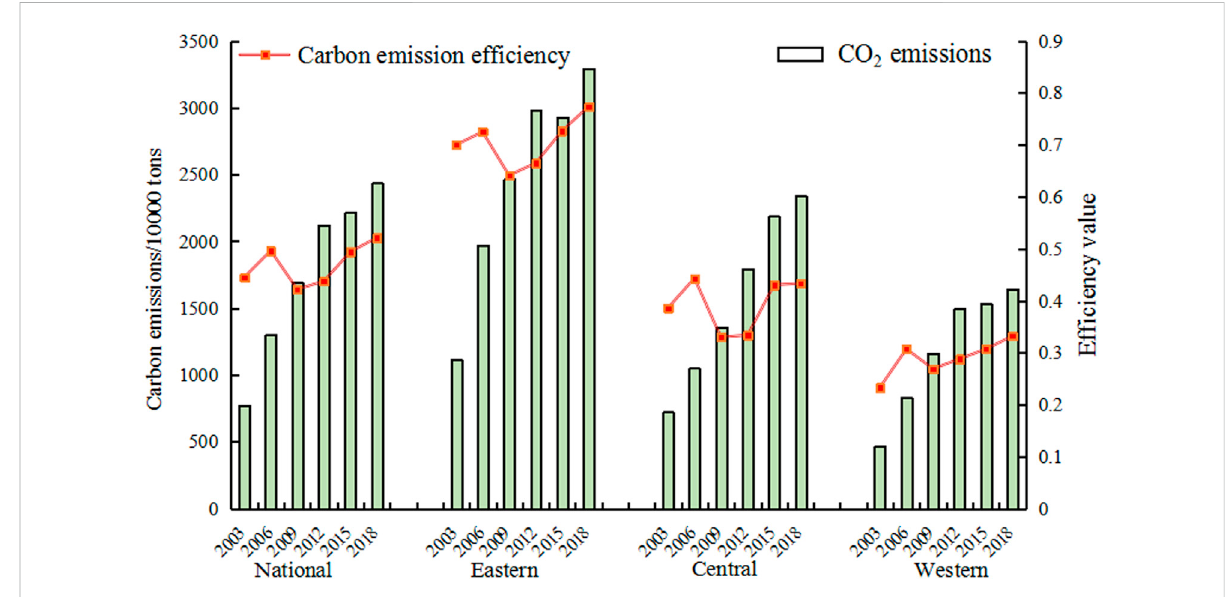
FIGURE 1 Trends in the carbon emissions and carbon emissions ef fi ciency in the transport industry.